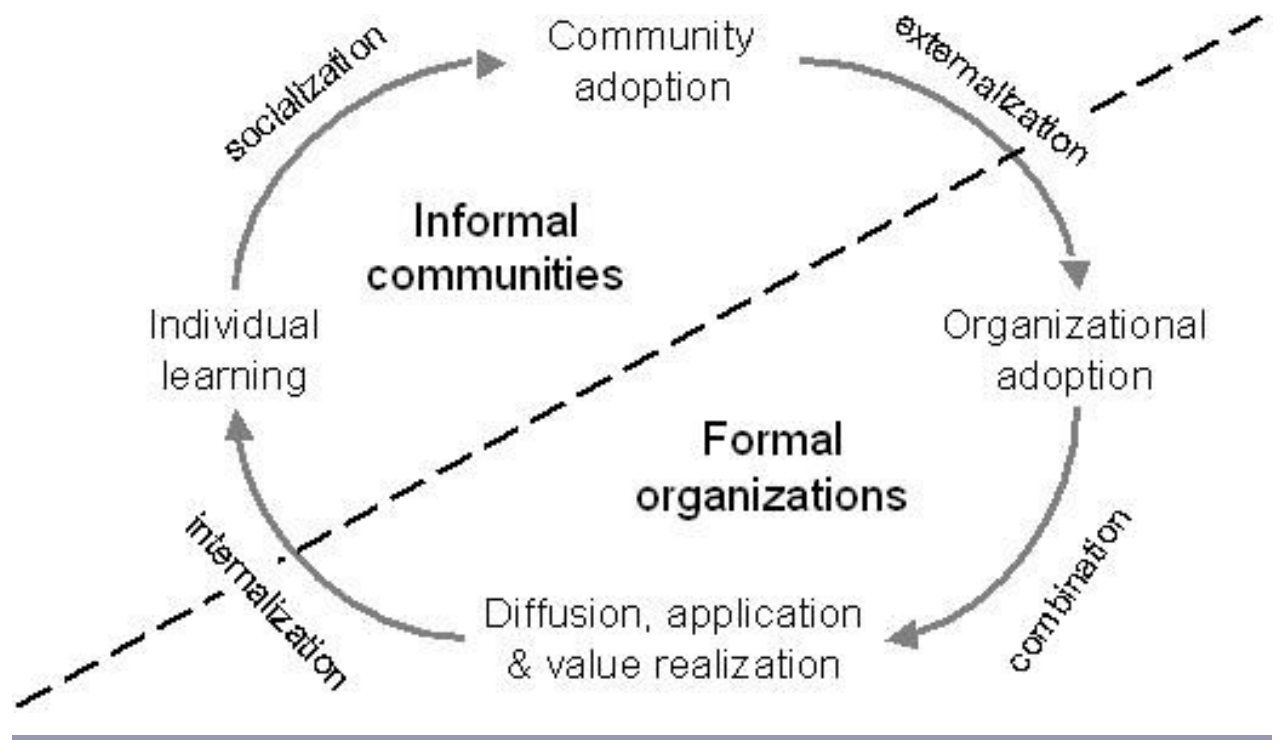
Fig. 1. Knowledge amplification from individual knowledge to institutional capability, based on Nonaka and Takeuchi’s (1995) four modes of knowledge